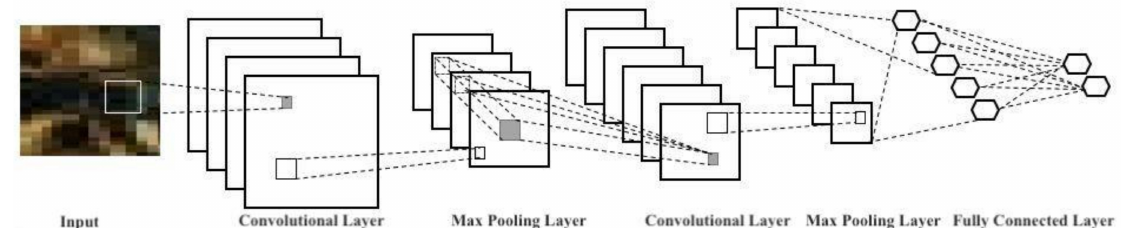
Figure 2. LeNet neural network of the palm oil tree